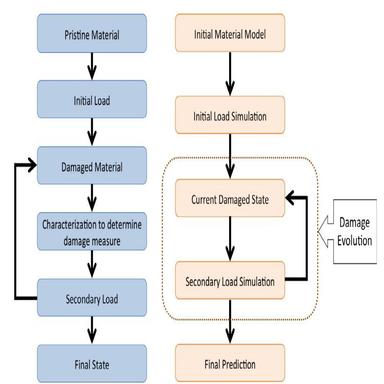
Left: schematic showing the experimental process developed for this study. Traditional experiments go directly from the initial load to the final state. Right: schematic showing common computational procedure for simulating loading with damage evolution.